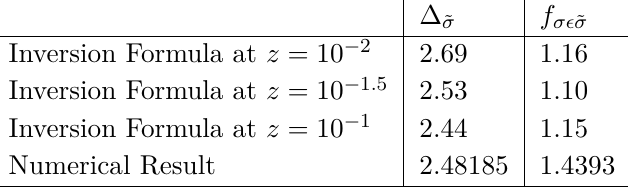
Table 3 . Twist and OPE coefficient of spin-0 operator in [ σ(cid:15) ] trajectory estimated from the inversion formula, compared with the value derived from numerical